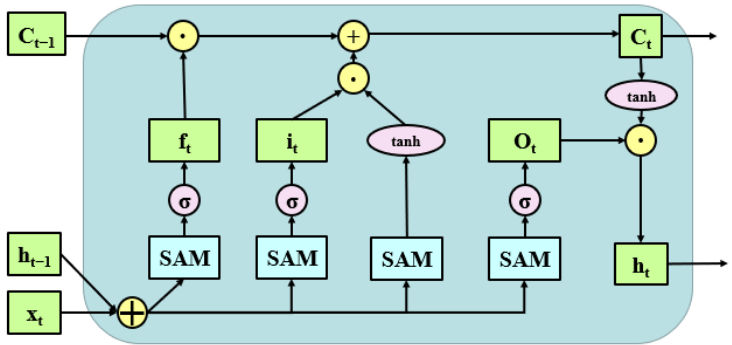
Figure 5. Spatial attention ConvLSTM (SA-ConvLSTM) model structure. Different from image data, vibration data are generally one-dimensional data, so the convolution kernel in SAM is set to 1 × 7. The specific formula for SA-ConvLSTM is as